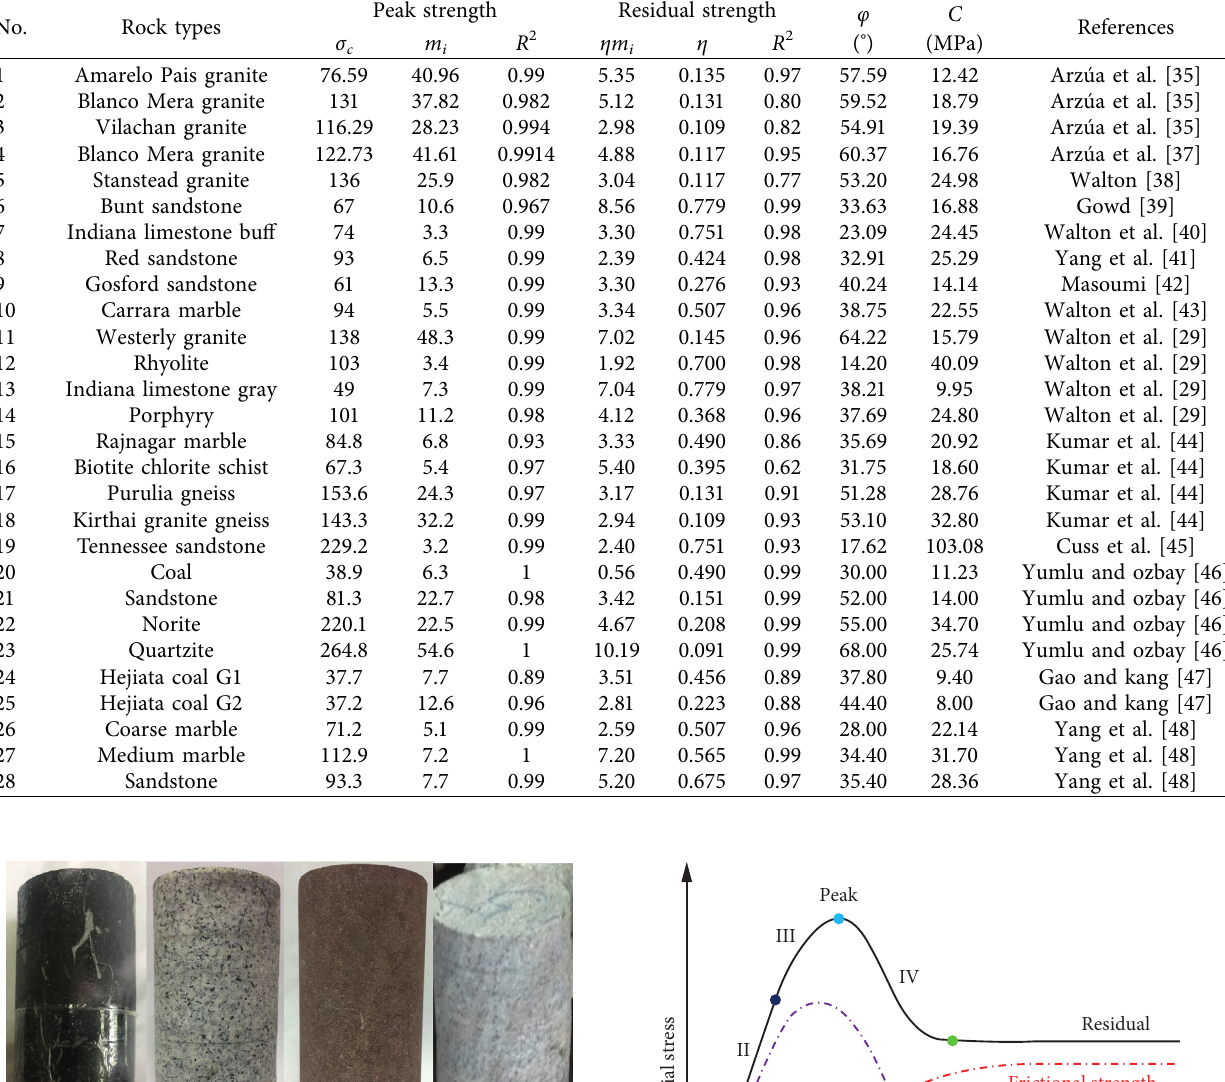
Table 1: Fitted parameters of the peak and residual strength using the H–B model and the proposed model.